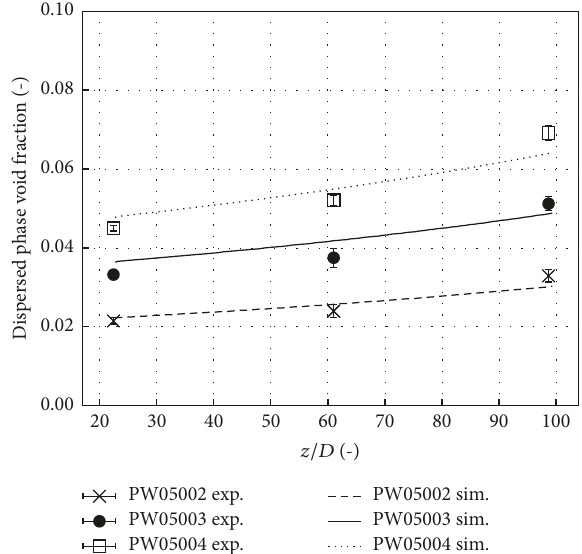
Figure 11: Comparison between computational results and experi- ments of the bubble mean size axial evolution. Figure 12: Comparison between computational results and experi- ments of the void fraction axial evolution.